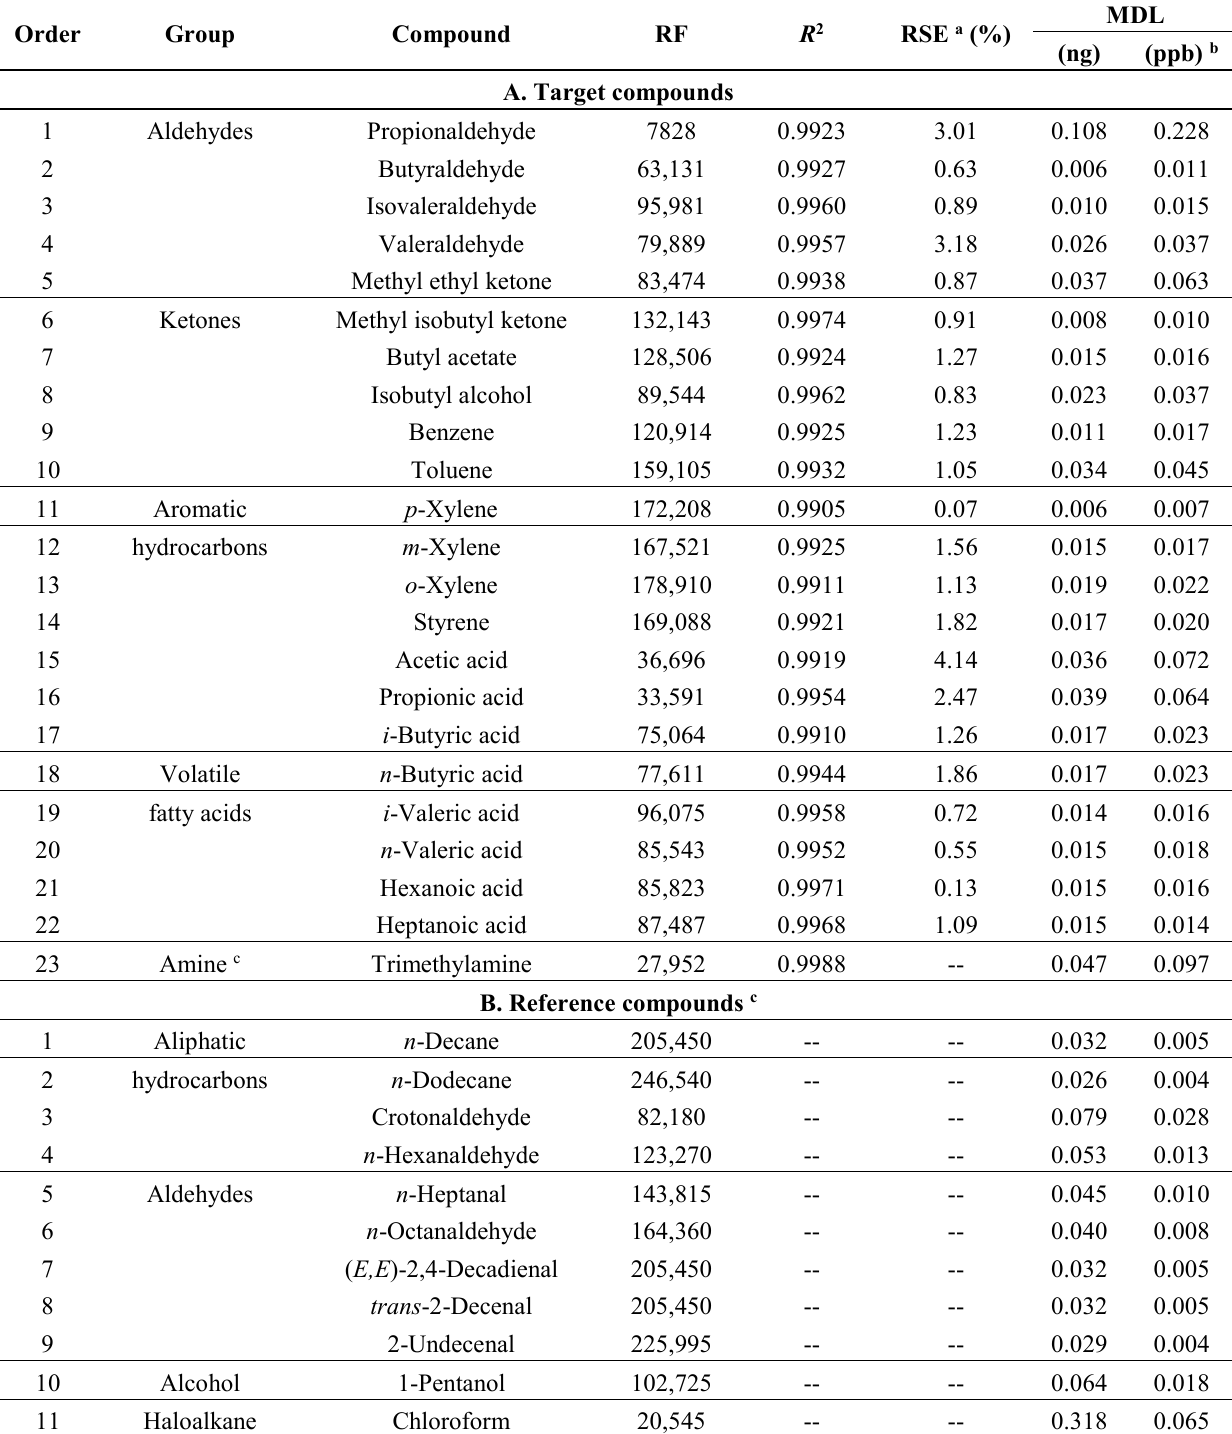
Table 4. Results of ST-TD-GC-MS based-calibration of VOC and the basic QA parameters determined in this study: comparison of response factor (RF), R 2 , and relative standard error (RSE, %) and method detection limit (MDL, ng and